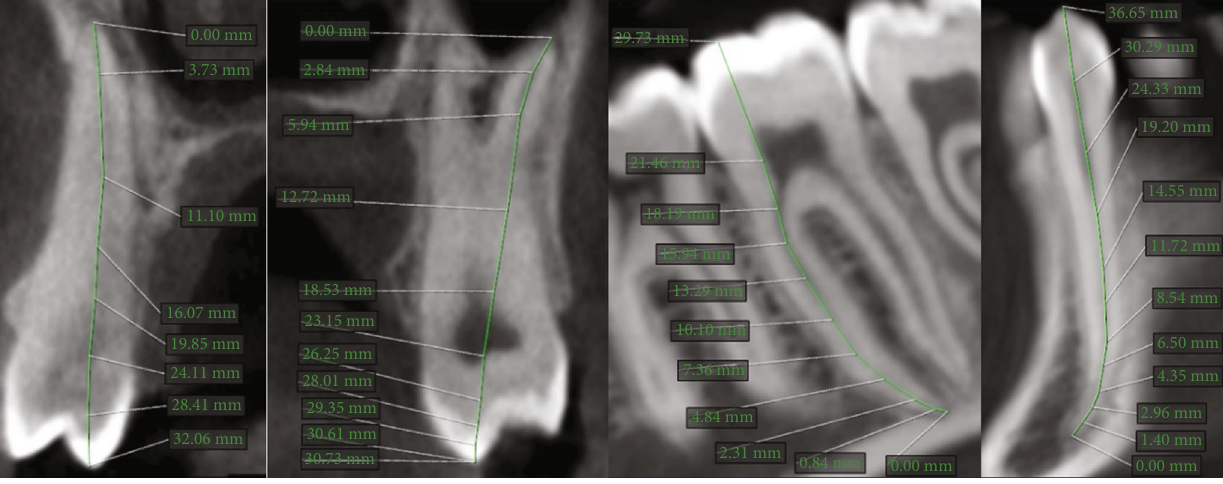
Figure 4: Sagittal section from cone beam computed tomography (CBCT) showing tooth sizes with